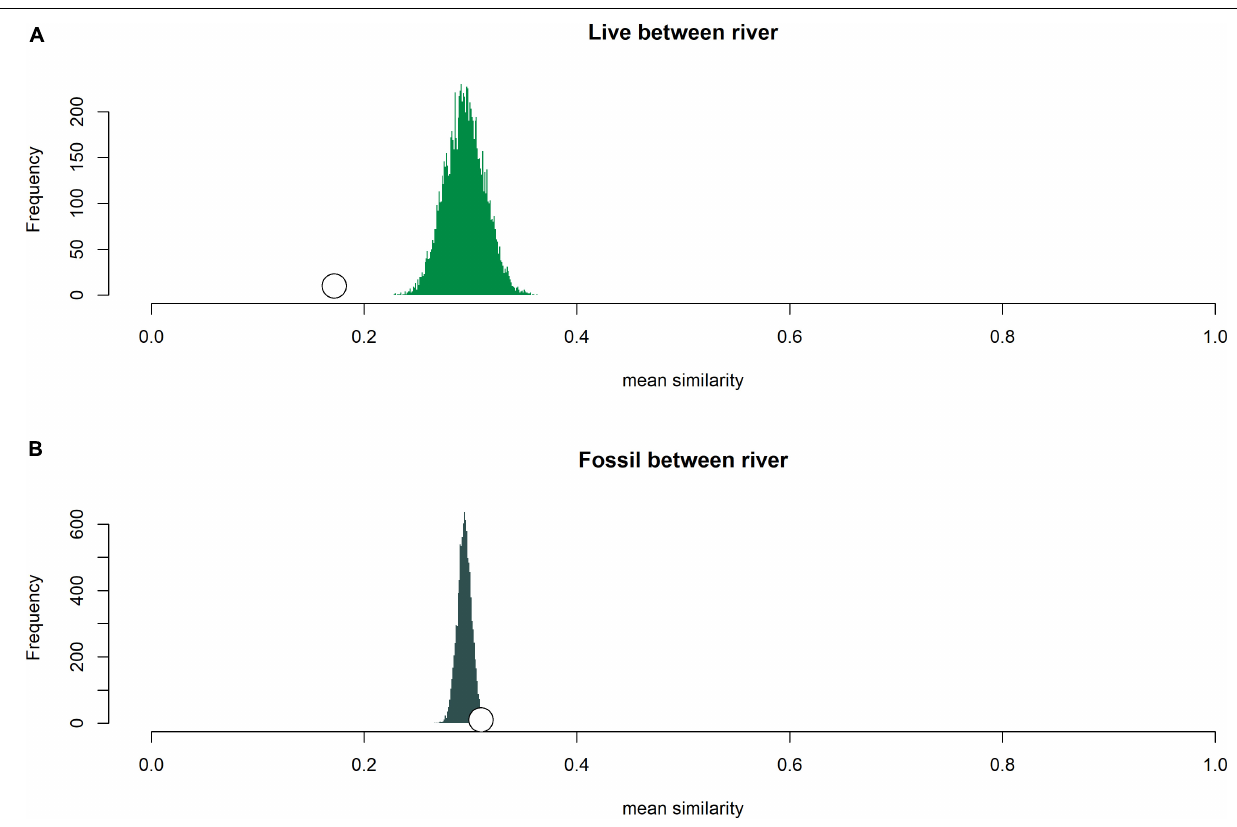
FIGURE 4 | Comparison of expected mean similarity distributions (based on randomization under the null model that all pairwise comparisons came from the same underlying statistical population) with observed mean similarity values for within river (A) live samples and (B) fossil samples. Open white circle is the observed mean similarity for the given set of